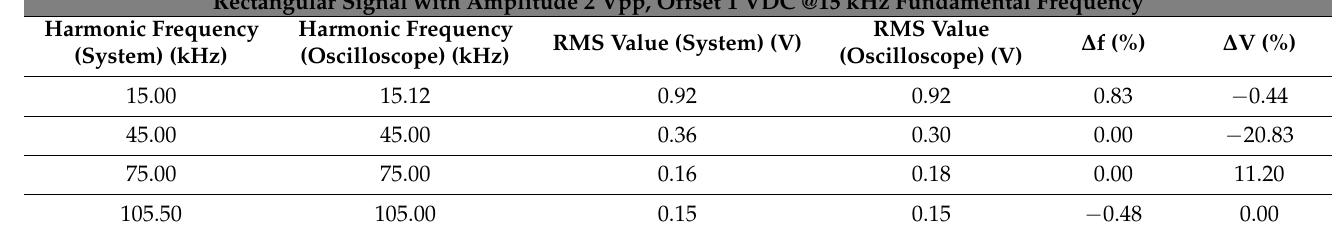
Table 7. Comparisons between the calibrated oscilloscope and the FPGA-based system measurements for rectangular signal with amplitude of 2 Vpp with 1 VDC offset value, for a signal’s fundamental frequency at 15 kHz.